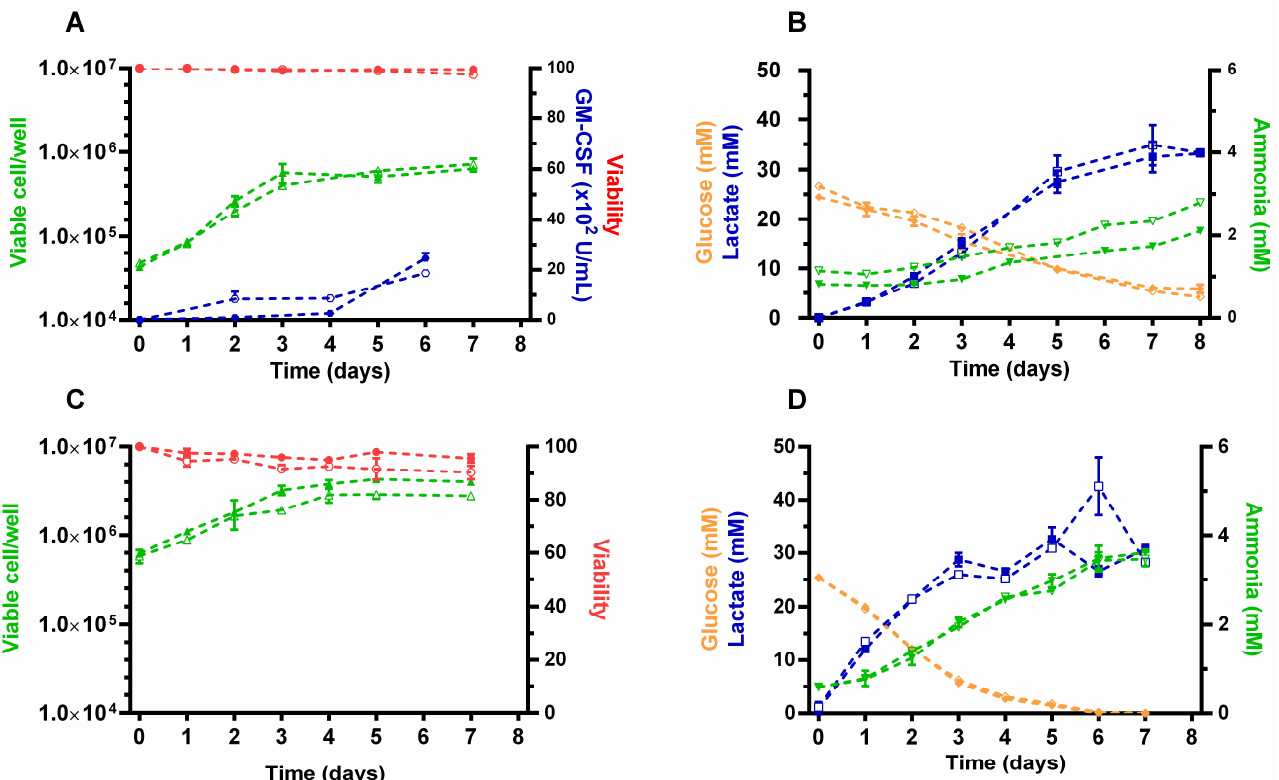
Figure 3. Growth phenotype and metabolism of redox reporter cell lines. Cell number (viable cells/well, △ ) , cell viability (%,◦), recombinant hGM-CSF activity (U/mL, ⬡ ), glucose (mM, ◊), lactate (mM, □), and ammonia (mM, ▽ ) were determined at different time points of batch cultures from ( A , B ) CHO-K1-hGM-CSF and ( C , D ) HEK-293 cell lines, where the filled and empty symbols correspond to data from the parental and the redox reporter cells, respectively.